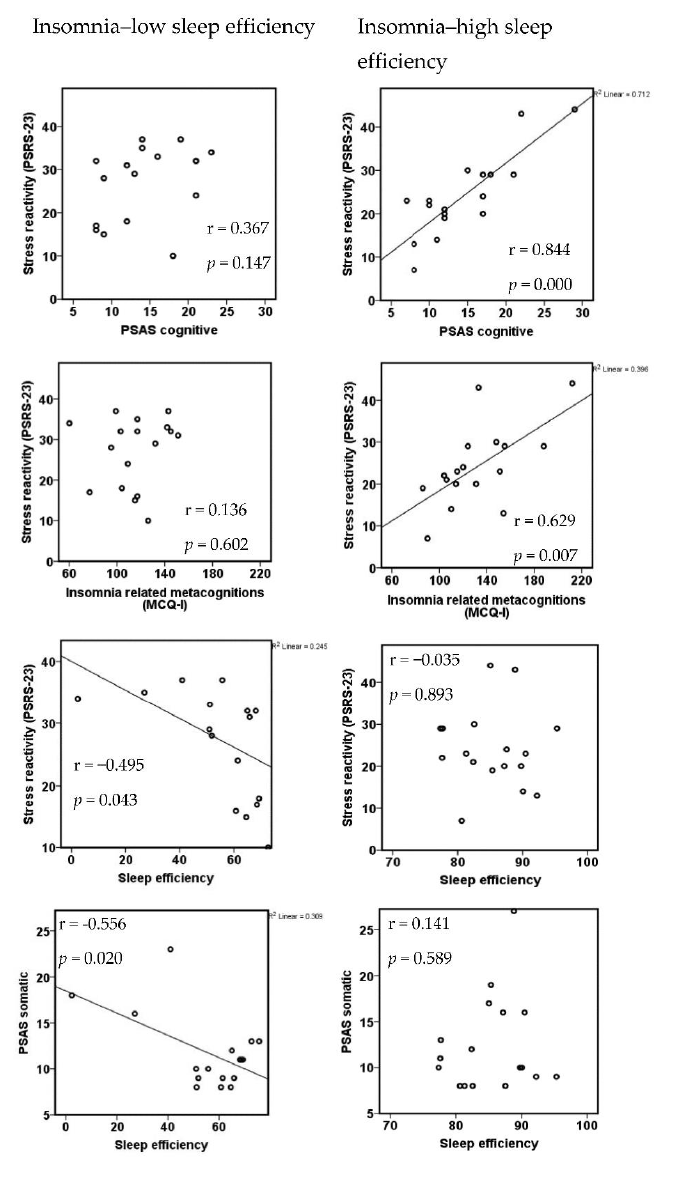
Figure 5. Different psychophysiological mechanisms in insomnia subgroups with high versus low sleep efficiency.